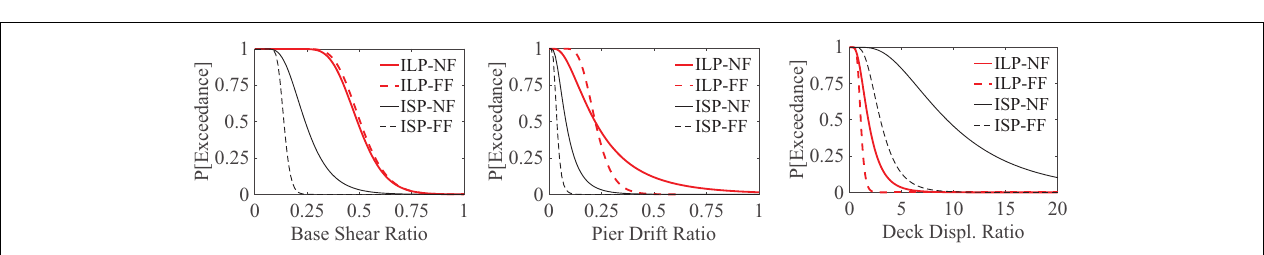
0 0.25 0.5 0.75